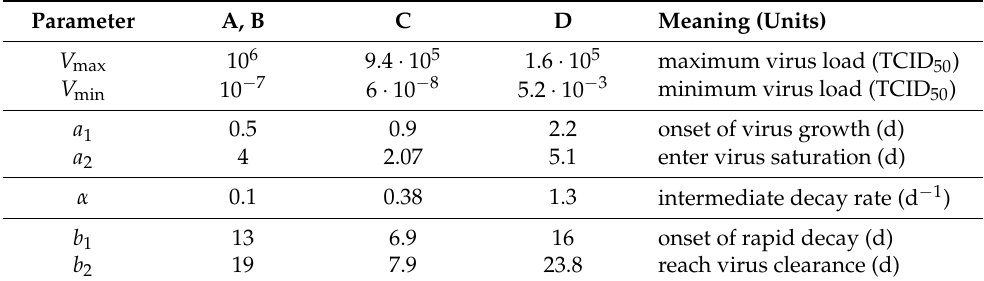
Table 1. Parameters of the standard virus load function (1) corresponding to Figure 1A–D. The virus load curves reported in [10] are used in (a) and